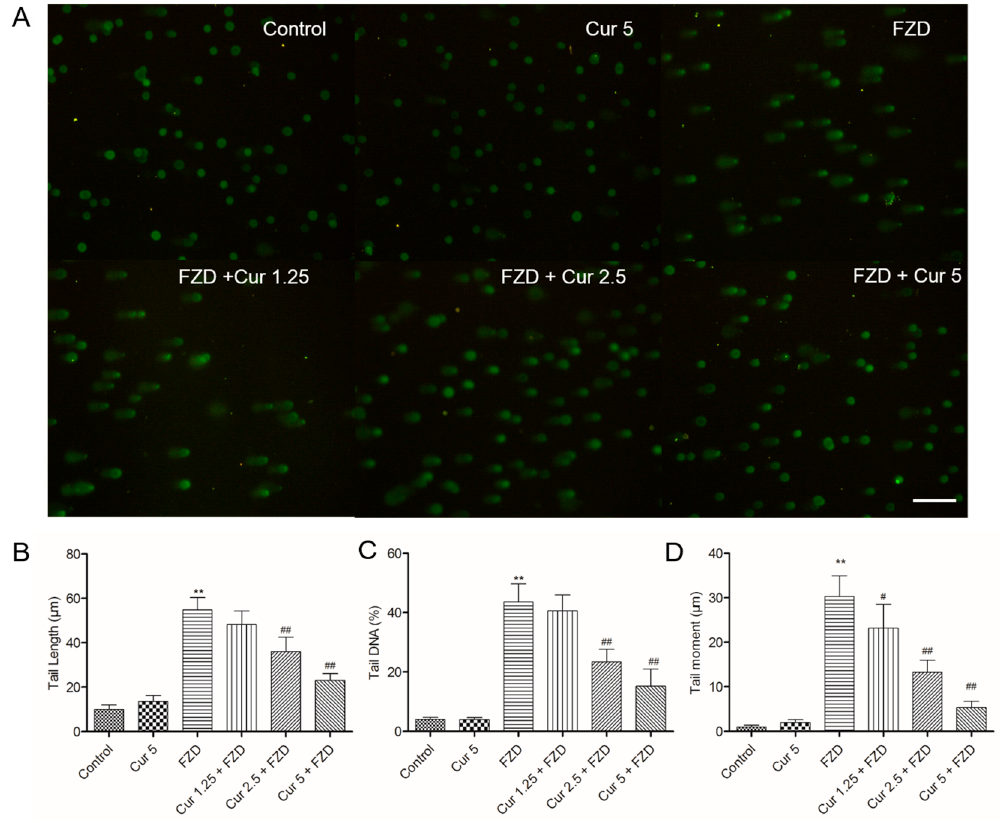
Figure 6. Curcumin treatment reduces FZD induced DNA injury in L02 cells. L02 cells were pretreated with curcumin at 1.25, 2.5 and 5 µM for 2 h, followed to wash with PBS twice and treat with or without FZD at 40 µg/mL for additional 3h, alkaline comet assay was carried out to evaluate the DNA injury. ( A ) The typical DNA comet images were showed. Bar = 100 µm ( B – D ) represented the analysis results of tail length, tail DNA (%) and Tail moment (µm), respectively. Values were presented as mean ± SD from at least 100 cells. ** p < 0.01, compared to the negative control group; # p < 0.05, ## p < 0.01, compared to the FZD alone group.